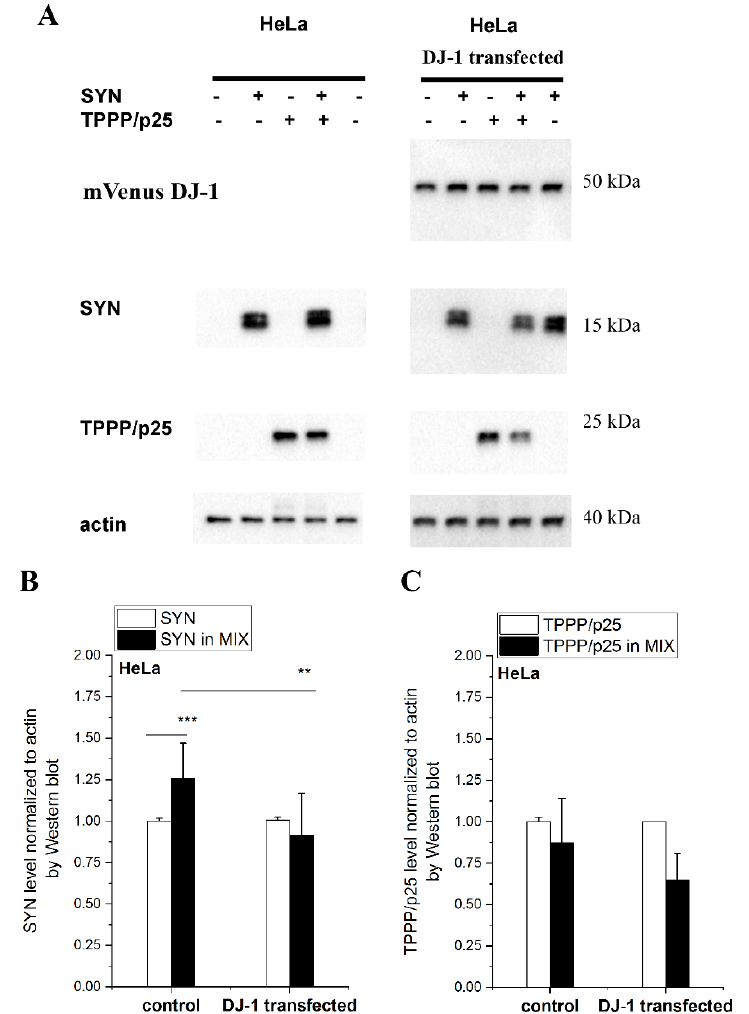
Figure 4. The effect of DJ-1 on the level of the degradation-resistant SYN and TPPP/p25. TPPP/p25 and/or SYN were taken up from the medium by the HeLa cells transfected with DJ-1. ( A ) Representative Western blots using cellular extracts without or with transfected DJ-1. The transfected mVenus-DJ-1 was quantified using GFP antibody. Actin as a loading control is also shown. ( B , C ) Proteins levels of SYN ( B ) and TPPP/p25 ( C ) were quantified by Western blot, as described in the Material and Methods. Data are normalized with respect to the added hallmark protein alone (SYN or TPPP/p25), and presented as the mean ± SD of at least 3 independent experiments. Statistical comparisons were performed with a Kruskal–Wallis non-parametric test (*** p < 0.001 and ** p < 0.01 compared to the control or as the lines indicate).